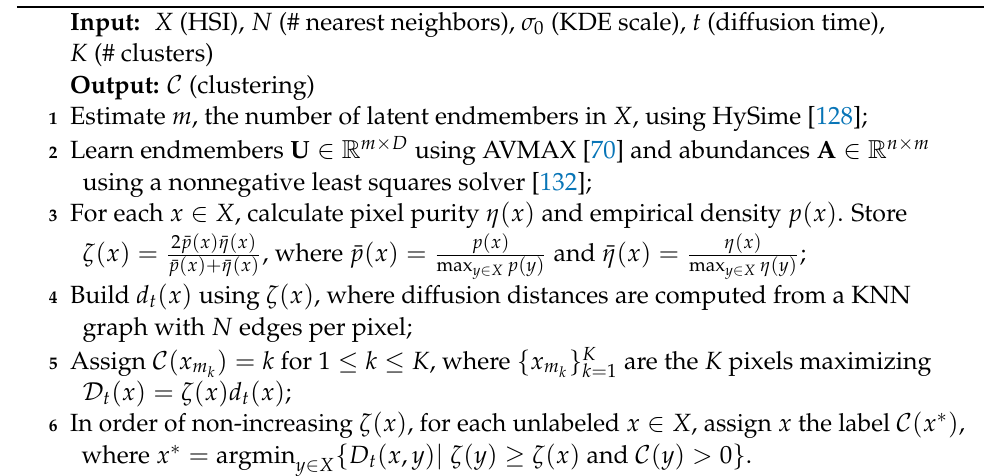
Algorithm 1: Diffusion and Volume maximization-based Image